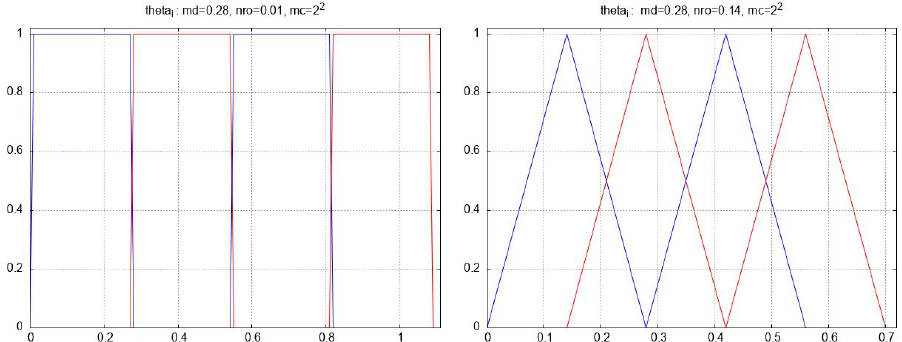
Figure 4. Sections in the direction of a coordinate axis passing through the center of the functions of a unity partition: δ = 0.01 ( left ) and δ = 0.14 ( right ).